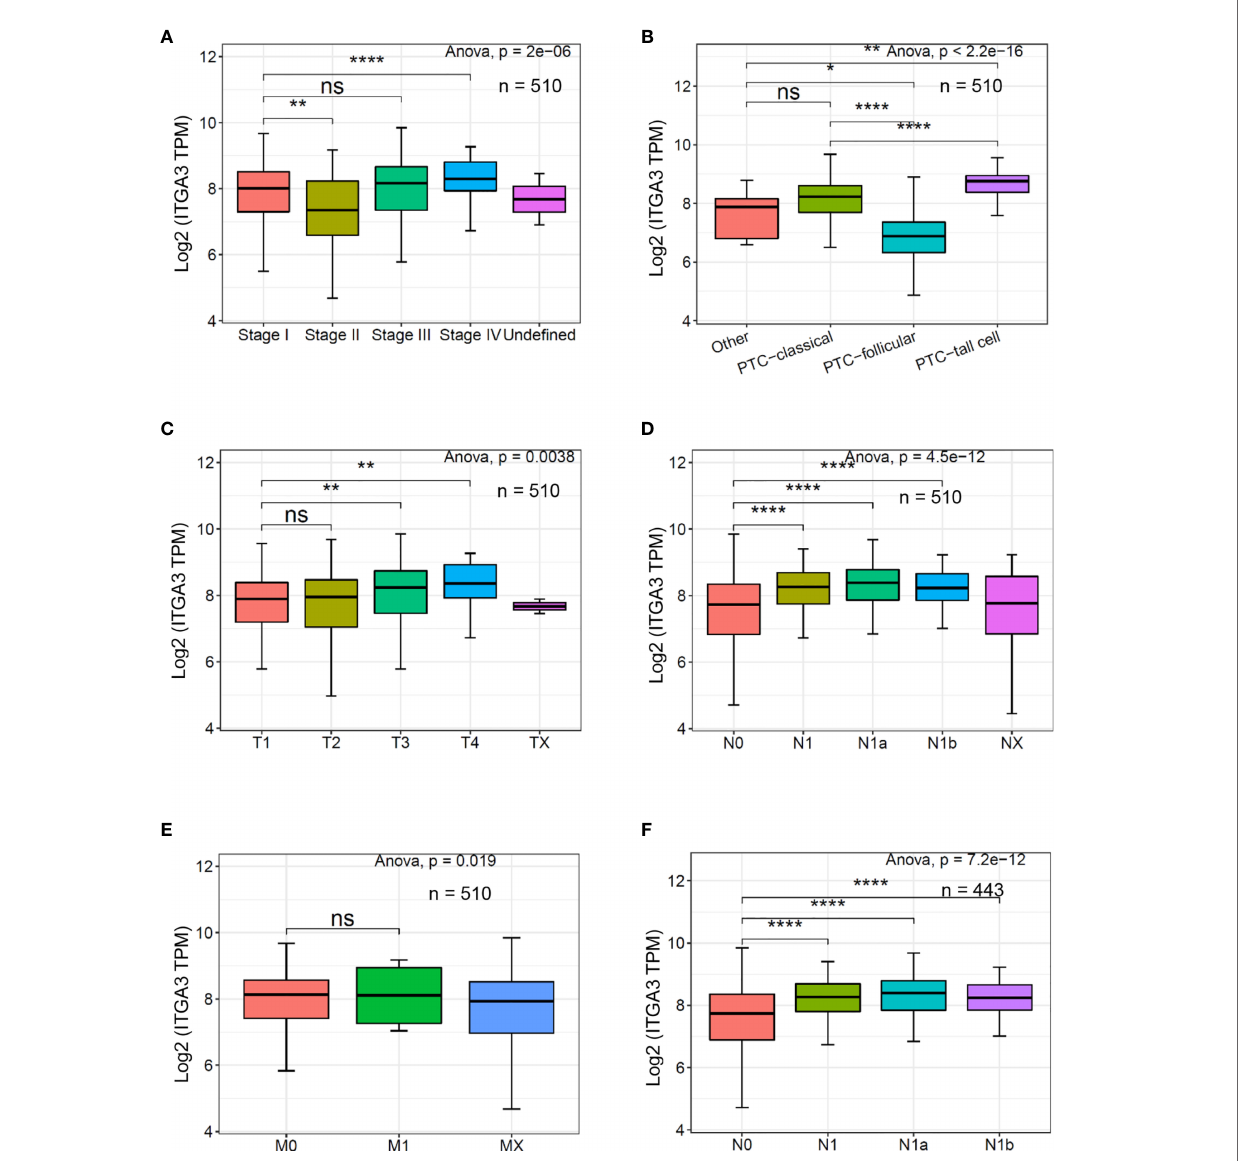
FIGURE 3 | The expression of ITGA3 in thyroid cancer with different clinicopathologic characters based on The Cancer Genome Atlas (TCGA) database. (A – E) The expression of ITGA3 in different pathologic stages, histological types, pathologic T stages, pathologic N stages, and pathologic M stages. (F) The expression of ITGA3 in different pathologic N stages in papillary thyroid cancer excluding the cases of non-papillary thyroid carcinoma and unde fi ned histological types. Statistical signi fi cance was determined by one-way ANOVA test. P < 0.05 was considered as the difference that was statistically signi fi cant (*P < 0.05, **P < 0.01,****P < 0.0001). ns, no signi fi